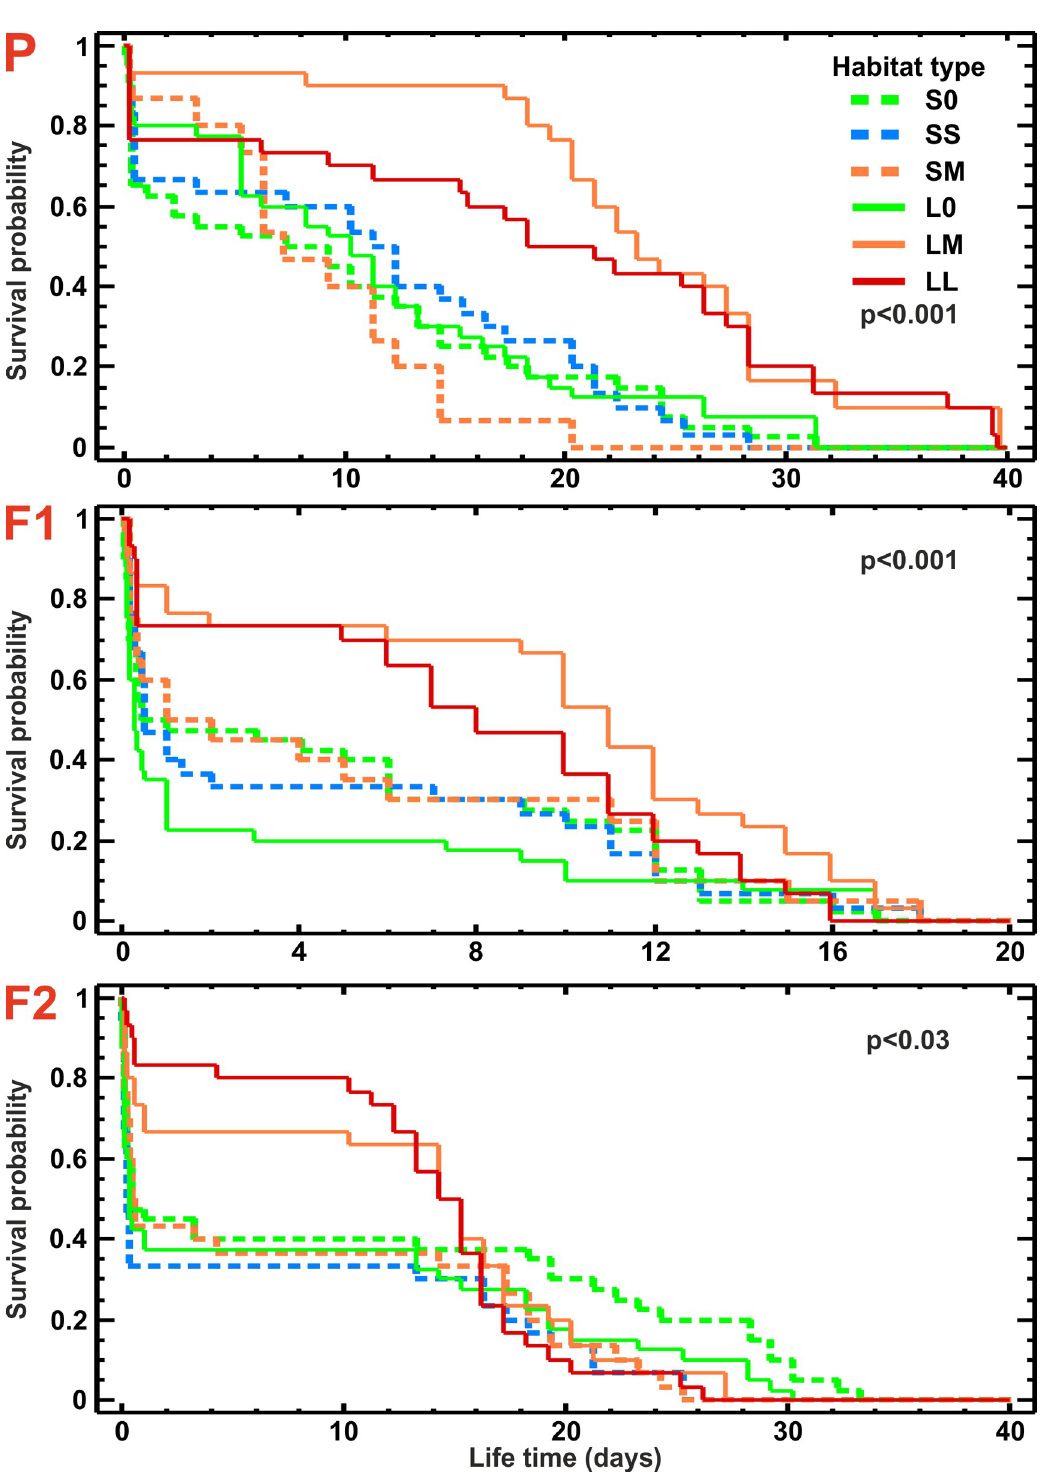
Fig 3. Survival curves of all three generations of Poecilus cupreus from different habitat types and landscapes after exposure to the insecticide Proteus 110 OD. Dashed lines stand for small-scale landscape; solid lines stands for large-scale landscape. The first character stands for landscape type: S–small-fields landscape, L–large-fields landscape; the second character stands for canola coverage: 0 –none, S–small (10–14%), M–medium (20–52%), L–large (80–98%). Red uppercase letters indicate generations: P– parental, F1 & F2 –laboratory breed. Note the generally shorter survival times in the first laboratory generation (F1).